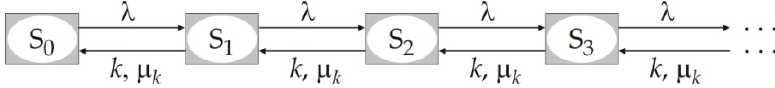
Figure 7. Markov queueing system with an Erlang distribution of services.